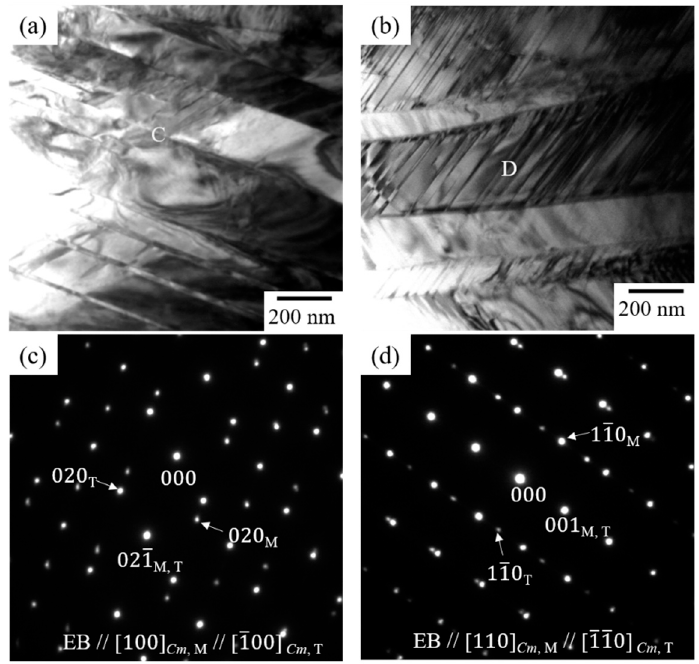
Figure 1. ( a , b ) Bright field images of water-quenched equiatomic CuZr alloy, and ( c , d ) electron diffraction patterns taken from the boundary C between martensitic variants in ( a ), and from the fine martensitic variants boundary D within the plate-like morphology in ( b ), respectively.